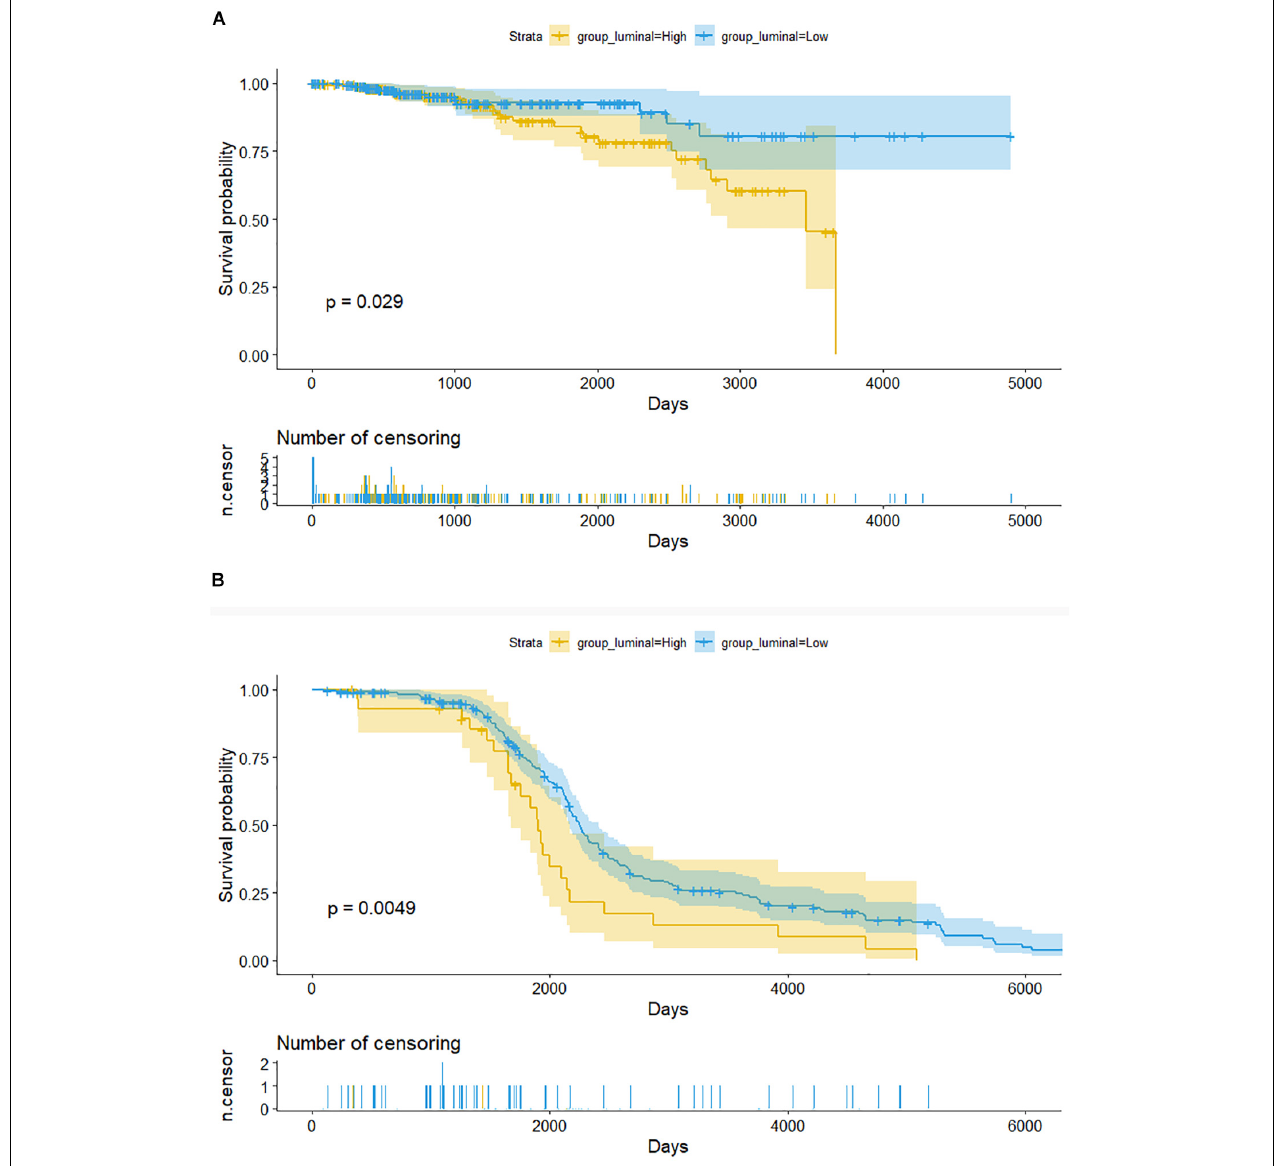
FIGURE 4 | Kaplan–Meier curves of overall survival in luminal breast cancer patients. (A) TCGA cohort. (B) GSE86166 cohort.